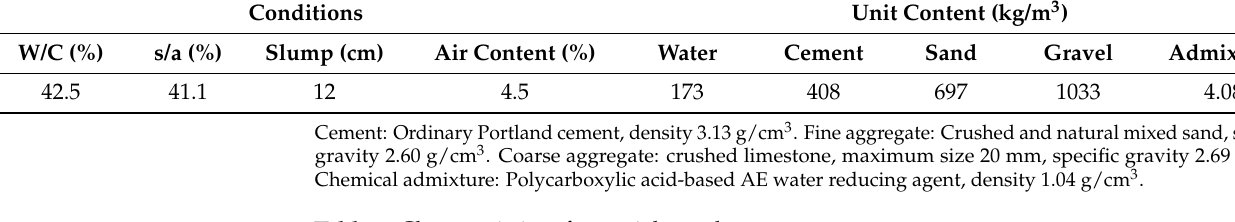
Table 3. Characteristics of materials used.